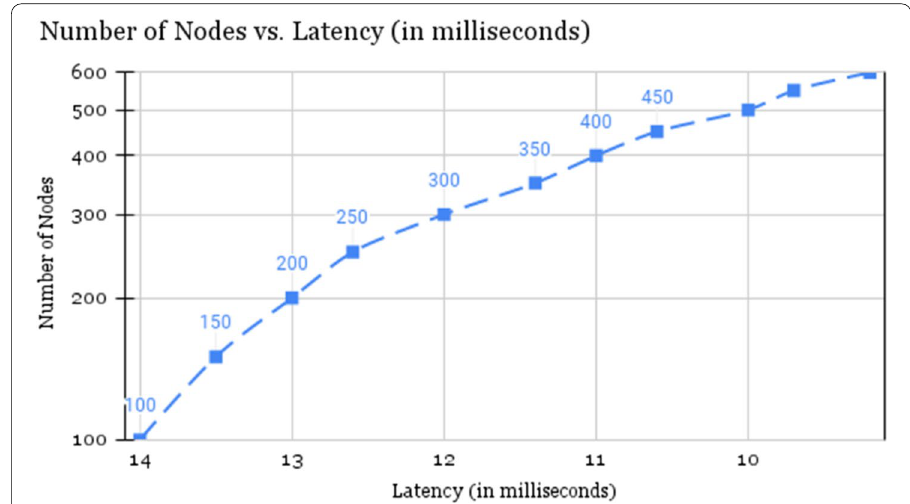
Fig. 3 Computational latency for the transaction authentication and data contact. This figure illustrates the computational time (latency (in milliseconds)) intake of node for adapted transaction authentication and records access on the existence of a diverse sum of partaking nodes. Amdahl’s law [19] was practiced to compute both parallel and serial transactions. The investigational outcome demonstrates that the transaction authentication time is larger than the data access time. This is for the reason that numerous authentications such as accounts, exist. Moreover, the admittance to meta-data and endorsement of the transaction is not process intensive, which result in efficiency (in terms of